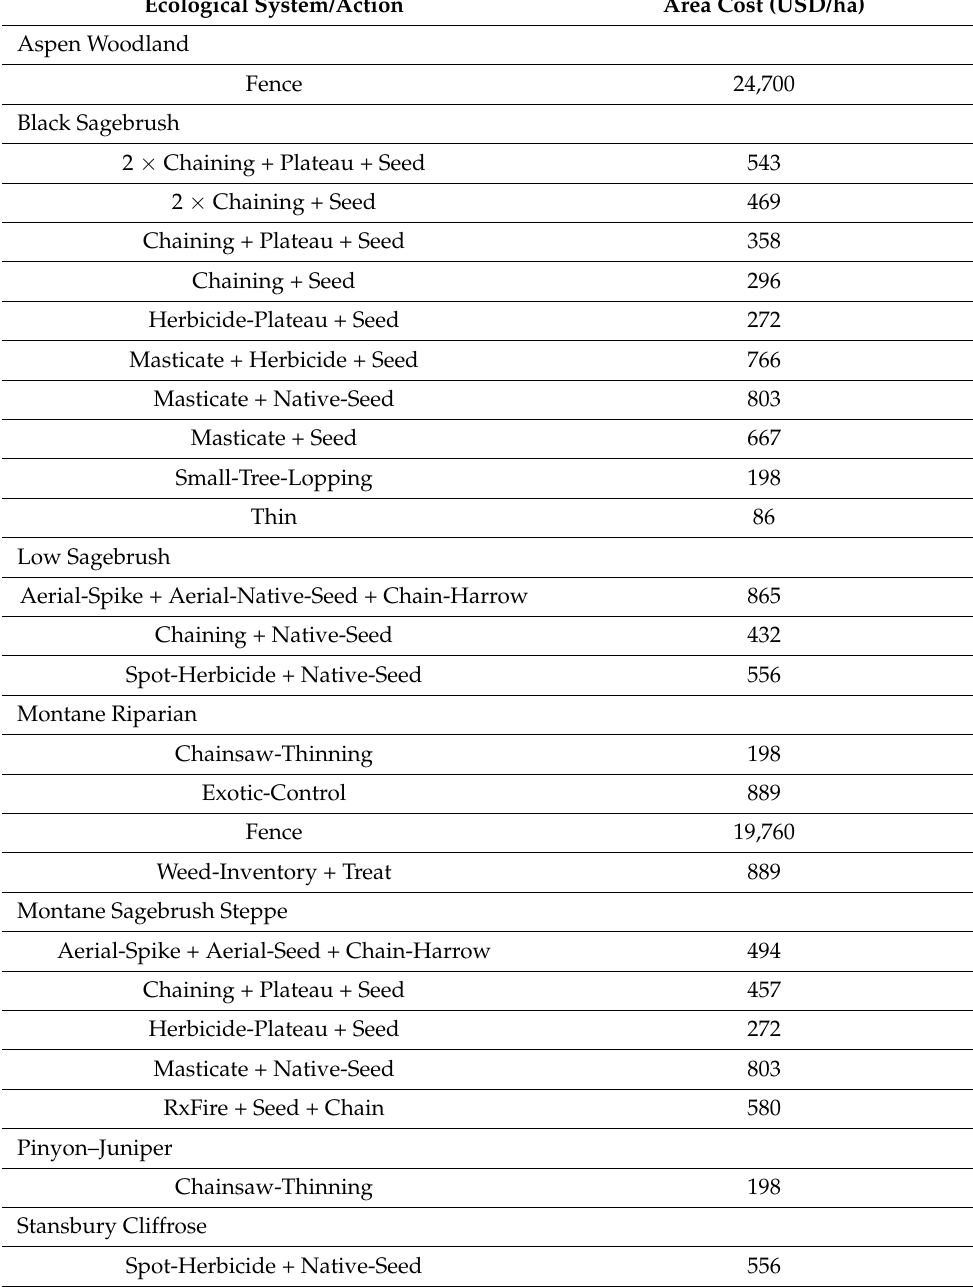
Table 4. Cost of management actions per unit area (USD/ha). Note: Plateau ® is the commercial name for the herbicide imazapic that inhibits seed germination of annual plant species. Ecological